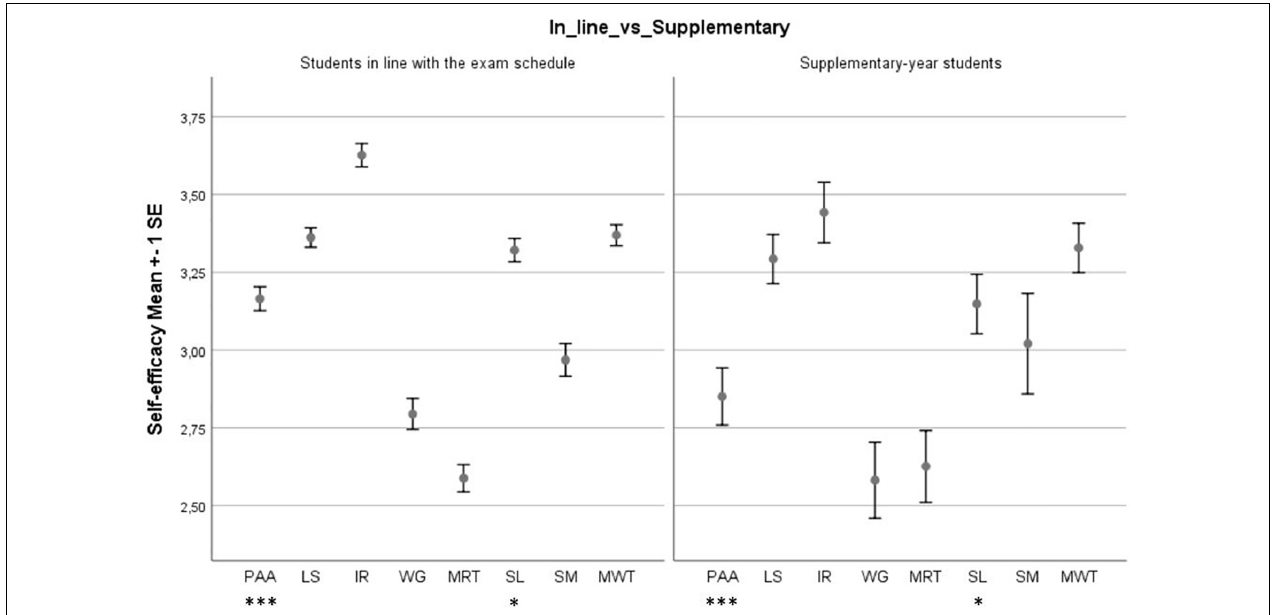
FIGURE 3 | Mean levels of the Academic Self-efficacy factors for students in line with the exam schedule vs. supplementary-year students and t -test results. ∗ p < 0.05; ∗∗∗ p < 0.001; PAA, “Planning Academic Activities”; LS, “Learning Strategies”; IR, “Information Retrieval”; WG, “Working in Groups”; MRT, “Management of Relationships with Teachers”; SL, “Skills for Lessons”; SM, “Stress Management”; MTW, “Management of Thesis